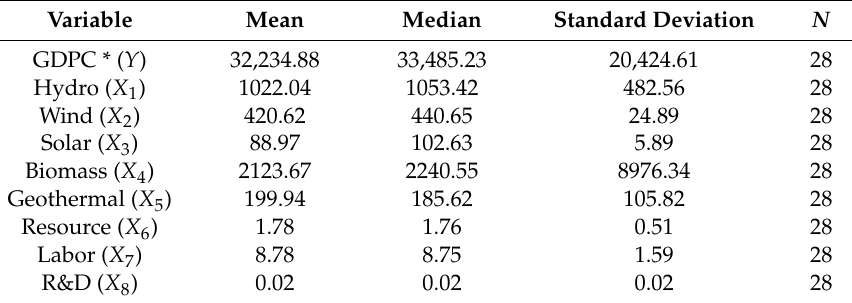
Table 3. Description of the model’s